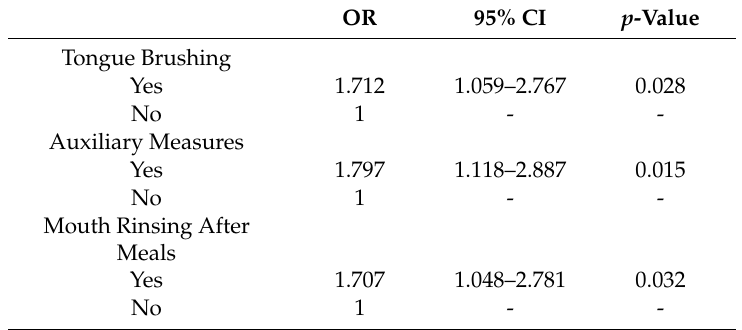
OR—odds ratio; CI—confidence